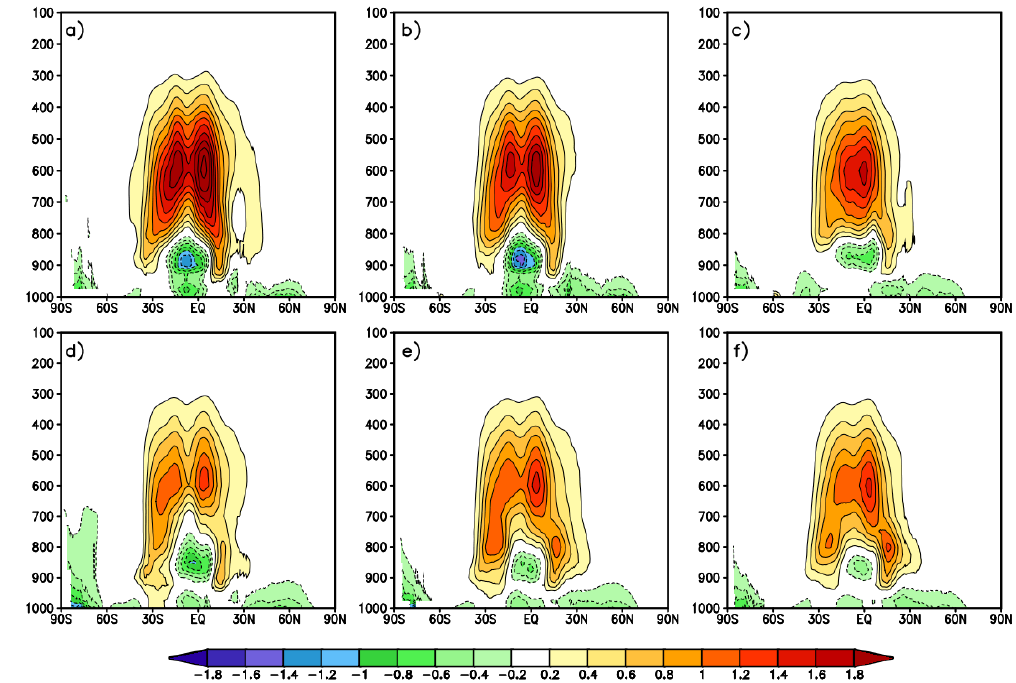
Figure 16. December-January-February seasonal mean difference of specific humidity in gkg − 1 for (a) MERRA-like AGCM – ERA-Interim at 2-degree resolution, (b) MERRA-like AGCM – ERA-Interim at 1-degree resolution, (c) MERRA-like AGCM – ERA-Interim at 1 / 2-degree resolution, (d) MERRA2-like AGCM – ERA-Interim at 2-degree resolution, (e) MERRA2-like AGCM – ERA-Interim at 1-degree resolution, (f) MERRA2-like AGCM – ERA-Interim at 1 / 2-degree resolution.